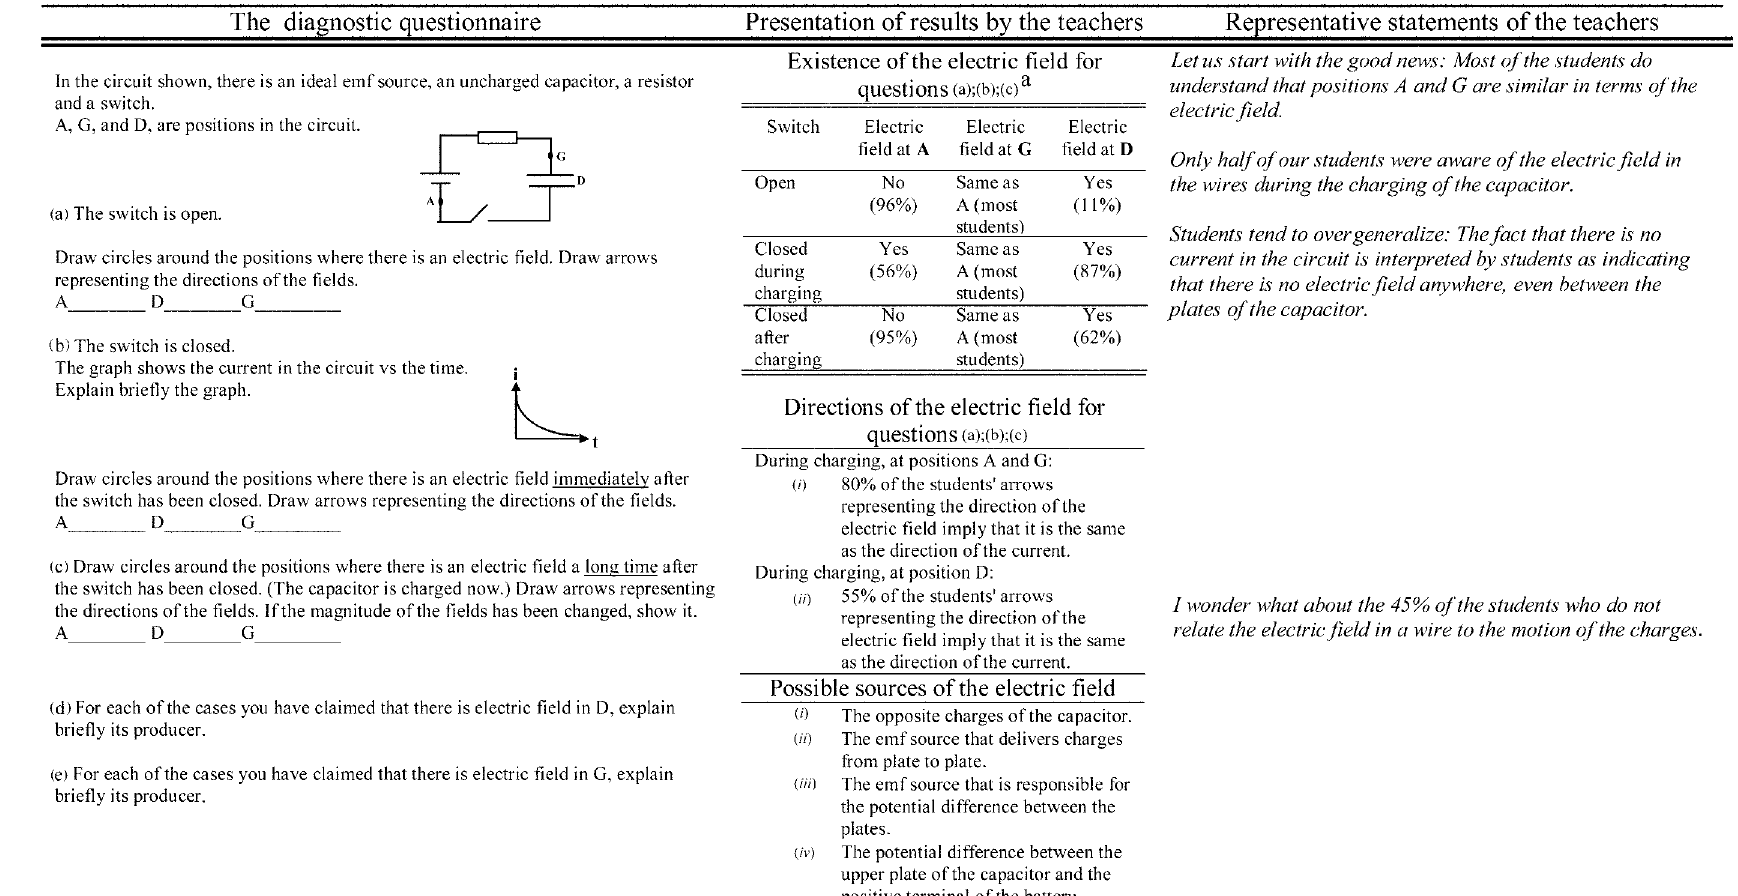
TABLE III. The diagnostic questionnaire designed by the teachers, their analysis of data collected from 93 high-school students, and statements from their presentation of the results in conference